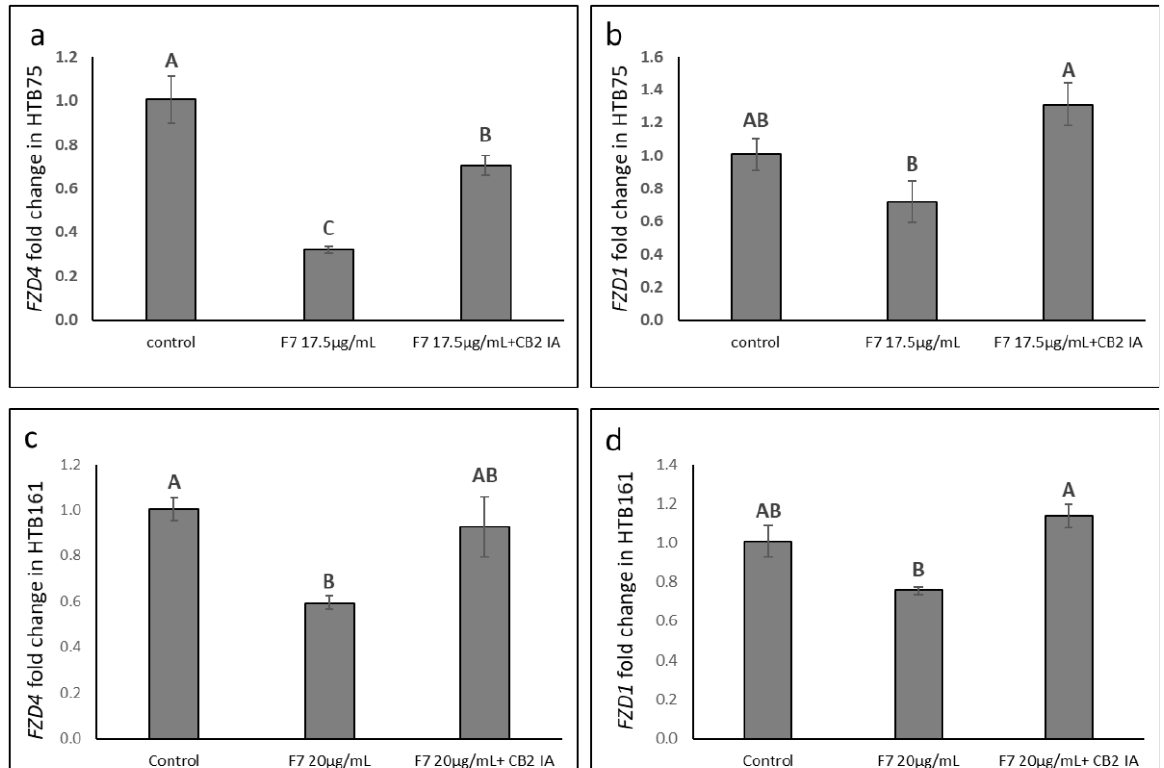
Figure 10. Quantitative PCR-based determination of the RNA steady state level in HTB75 ( a , b ) and HTB161 ( c , d ) cell lines of FZD4 and FZD1 genes at 6 h of treatment with F7 or F7+CB2 IA, relative to control. Gene transcript values were determined by quantitative PCR as a difference between the target gene versus a reference gene (HPRT). Values were calculated relative to the average expression of target genes in treated versus control using the 2 −ΔΔCt method. Control was the vehicle control (1.00% v/v methanol + 0.10% v/v DMSO). Error bars indicate ± S.E. ( n = 3). Levels with different Upper case letters were significantly different from all combinations of pairs by Tukey-Kramer honest significant difference (HSD; p ≤